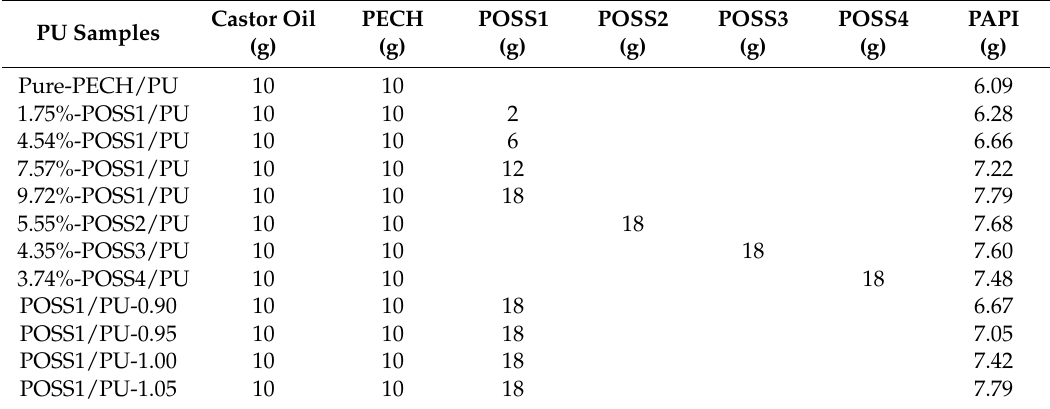
Table 2. Formulations of PU Table 2 Formulations of PU compositions